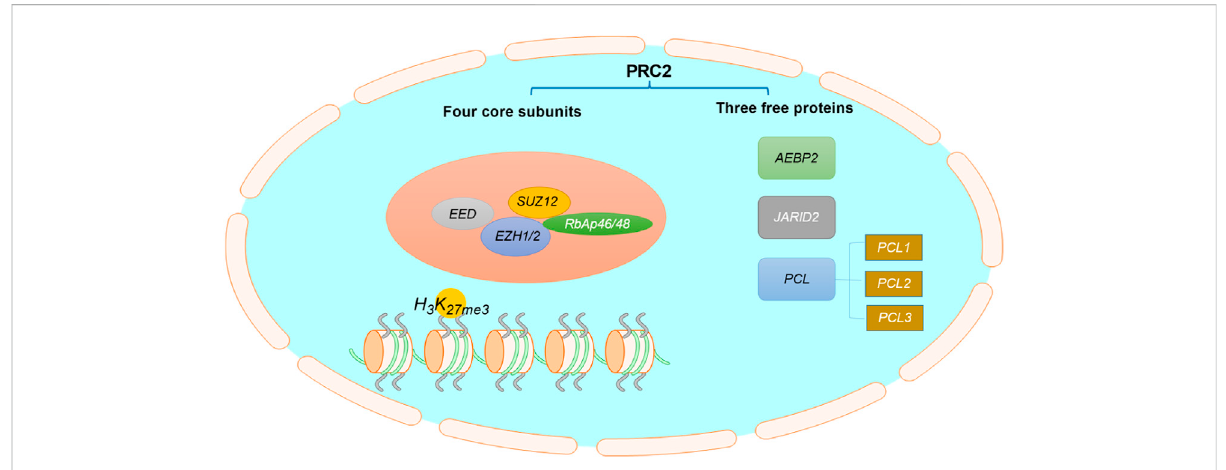
FIGURE 1 The structure of PRC2. PRC2 is composed of four core subunits: EZH1/2, EED, SUZ12, RbAp46/48, and three free proteins: AEBP2, PCLs and